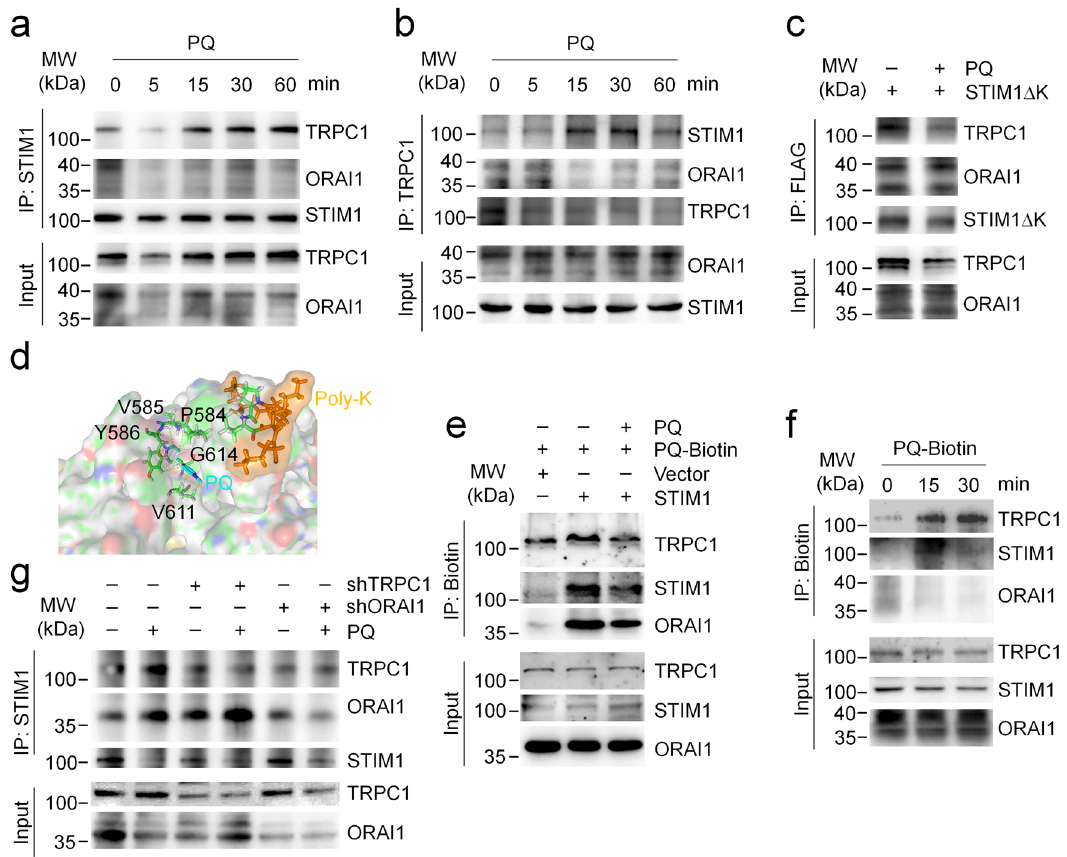
Fig. 3 PQ binds to STIM1 and activates the STIM1-TRPC1 axis. a – b Co – IP analysis of STIM1 association with ORAI1 or TRPC1 ( a ) or TRPC1 association with STIM1 or ORAI1 ( b ) in A549 cells treated with 800 μ M PQ for 0, 5, 15, 30, and 60 min as indicated. Images are representative of more than three experiments. c Co – IP analysis of STIM1 Δ K association with ORAI1 or TRPC1 in STIM1 Δ K-FLAG stably expressing A549 cells treated w/wo 800 μ M PQ for 24 hours. Images are representative of three experiments. d Molecular modeling of PQ and STIM1. The side view of the PQ-STIM1 complex in a surface representation showed potential residues in the C-terminal region of STIM1 forming a pocket for PQ that facilitates the exposure of the poly-K region. PQ is colored in cyan; potential residues of STIM1 for association with PQ is colored in green and the poly-K region of STIM1 is colored in yellow. e – f Pull-down analysis of PQ-Biotin and STIM1/ORAI1/TRPC1 association in A549 cells transfected to express empty vector or STIM1-GFP. Cells were treated with 800 μ M PQ-Biotin for 24 hours ( e ) or 0, 15, 30 min as indicated ( f ). Immunoblot was probed using the indicated antibodies. g Co – IP analysis of STIM1 association with ORAI1 or TRPC1 in A549 cells infected with shRNA-ORAI1 or shRNA-TRPC1, respectively, and treated with 800 μ M PQ for 24